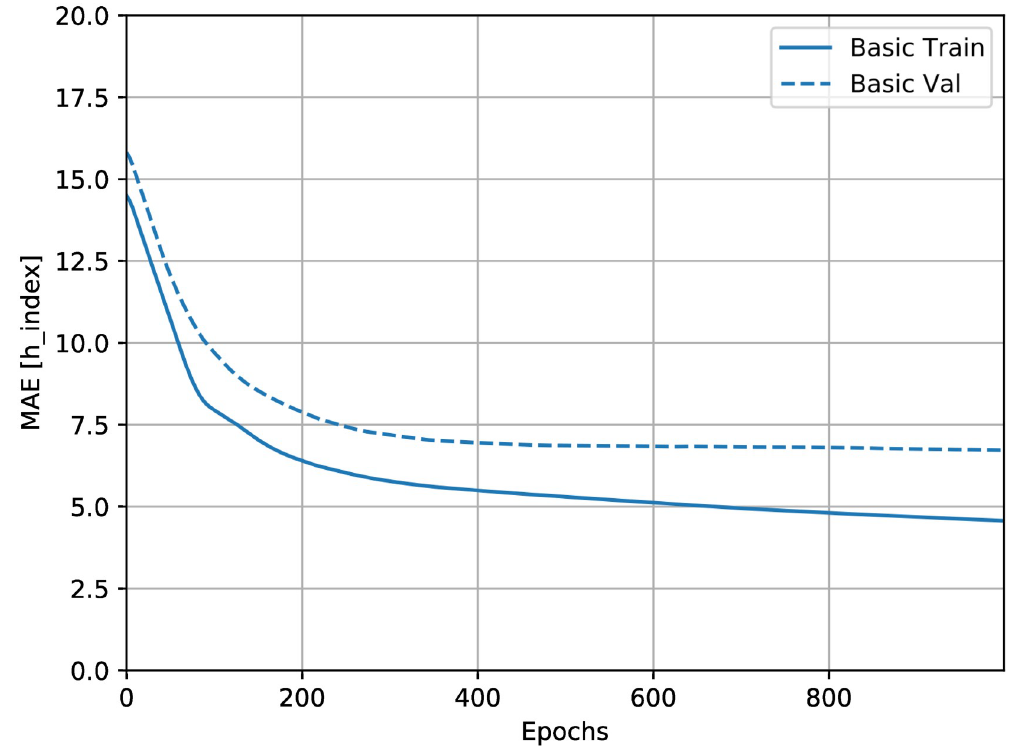
Fig 1. Mean average error over 1000 training epochs. Mean average error of the neural network, i.e. the average difference between the true and predicted author H-Index, for each epoch. After around 400 epochs, the network starts to overfit to the training data, as the training error rate continues to go down, while the validation error rate (shown as a dotted line) remains roughly constant.